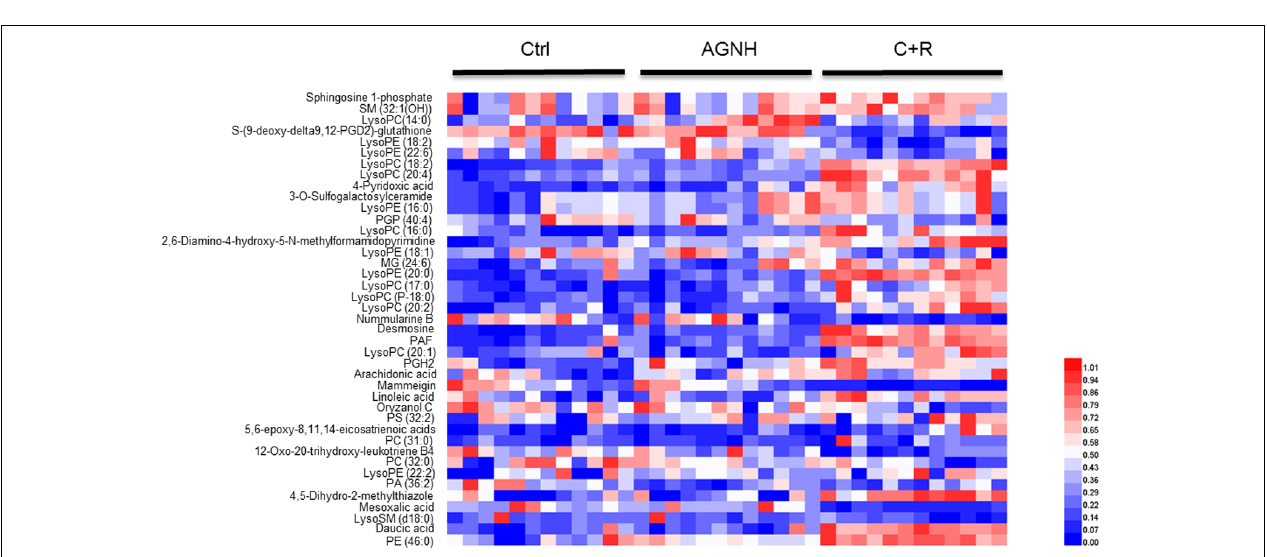
FIGURE 6 | Heatmap visualizing the changes in the contents of potential biomarkers in saline control (Ctrl), An-Gong-Niu-Huang Wan (AGNH) and cinnabar and reaglar co-administration (C+R) groups. Rows: biomarkers; columns: samples. Color key indicates metabolite content value. Blue color represents low metabolite content, while red refers to high metabolite